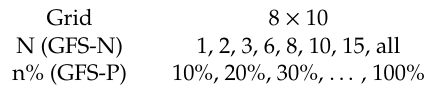
Table 4. GFS parameter settings.